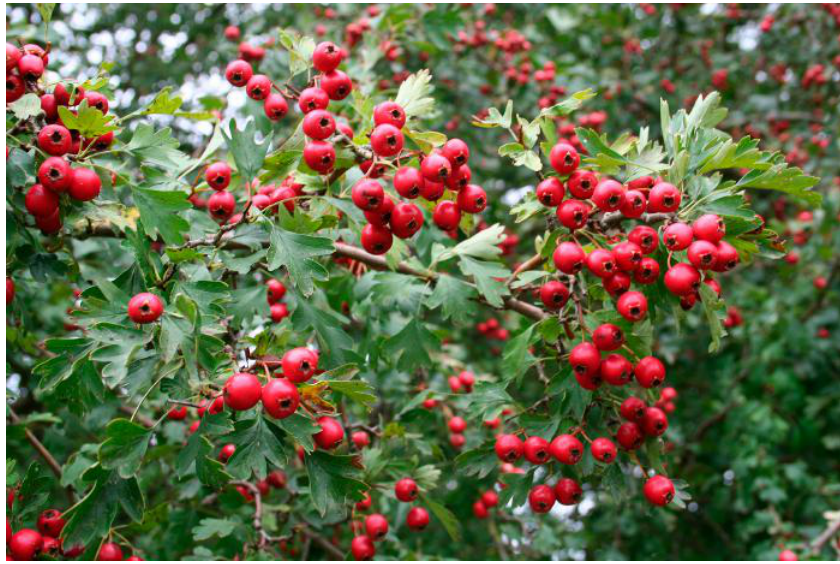
Figure 4. Hawthorn ( Crataegus oxyacantha L.)